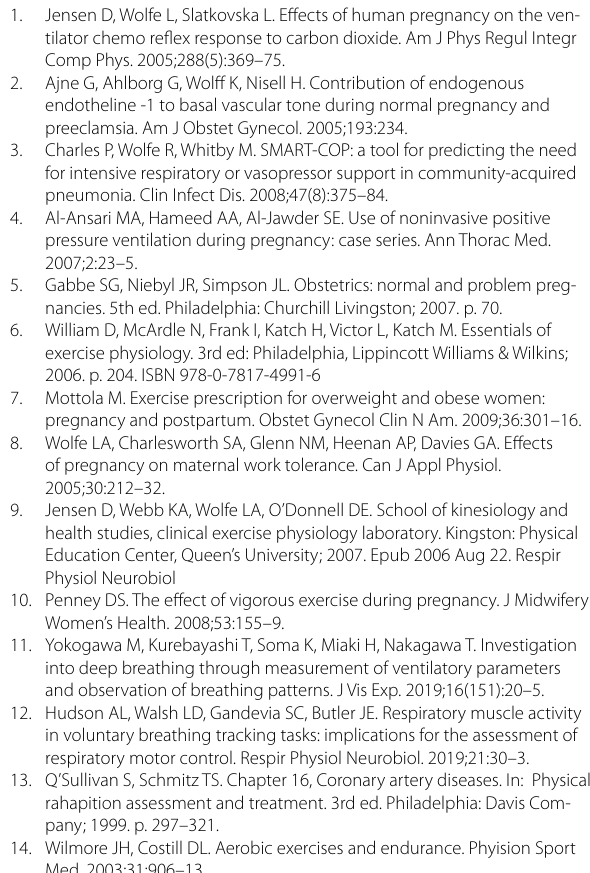
table consensus statement: impactof physical activity during preg- nancy and postpartumon chronic disease risk. Med Sci Sports